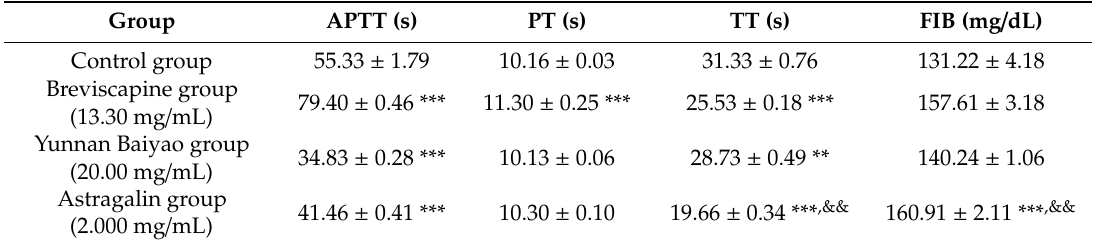
Table 1. The results of coagulation four indices of samples (X ± SD, n =